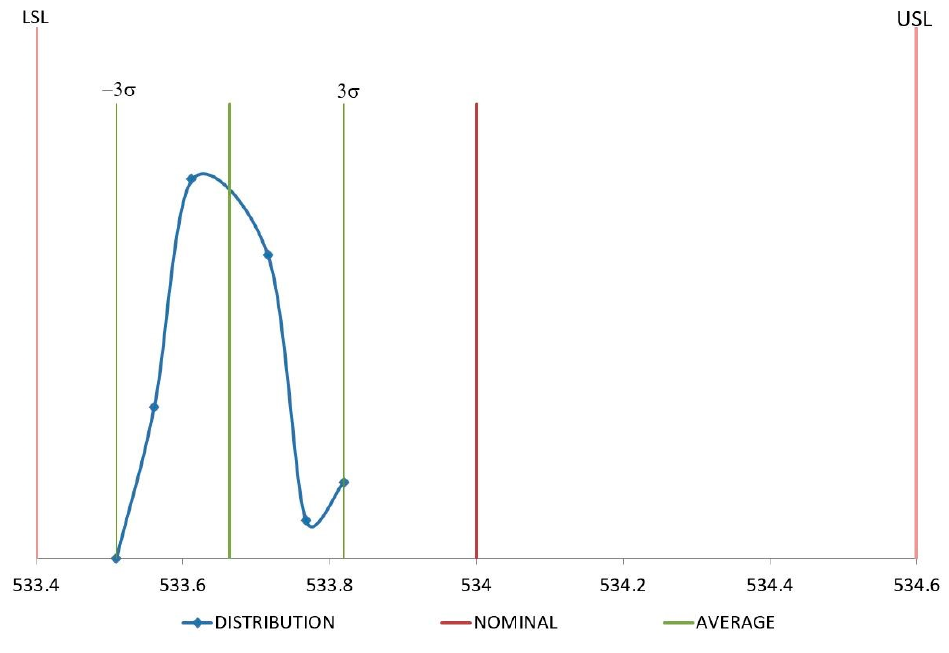
Polymers 2019 , 11 , x FOR PEER REVIEW Figure 10. Distribution for D1 (mm) with recycled material. Figure 10. Distribution for D1 (mm) with recycled material.